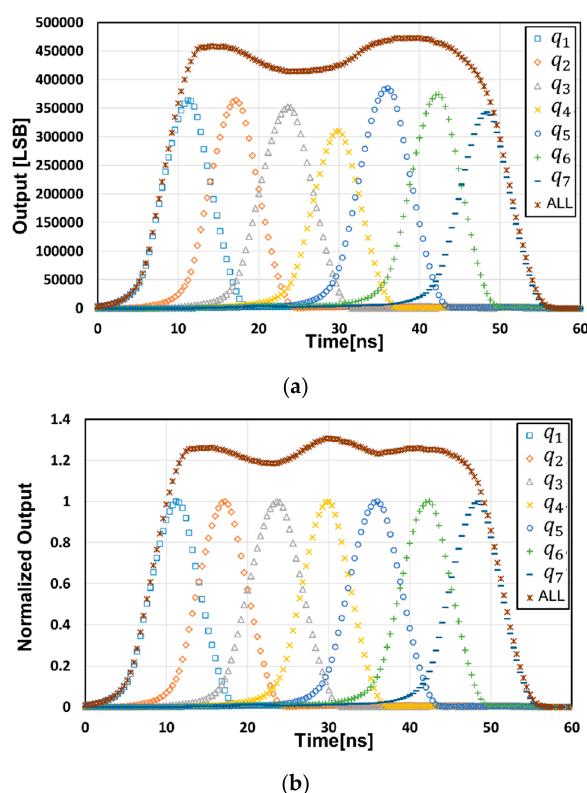
Figure 8. Response of the seven signal-tap outputs to the light pulse delay: ( a ) measured raw data and ( b ) the normalized data.